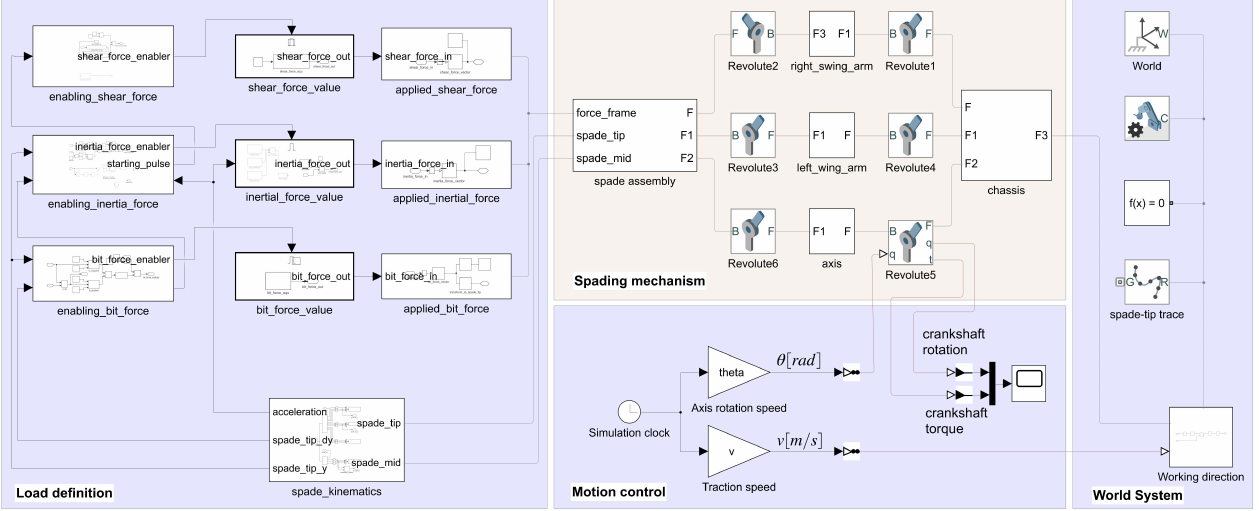
Figure 4. The Matlab ® Simscape™ model of the spading mechanism (with one spade